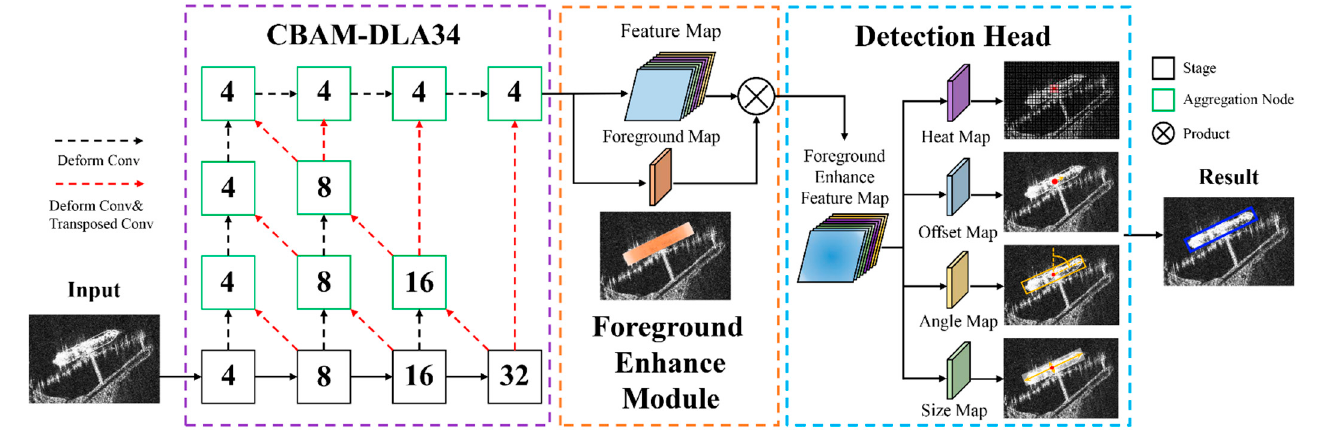
Figure 4. The architecture of R-Centernet+, which mainly consists of the CBAM-DLA34, FEM, and Improved Detection Head. The numbers in the boxes represent the stride to the image.